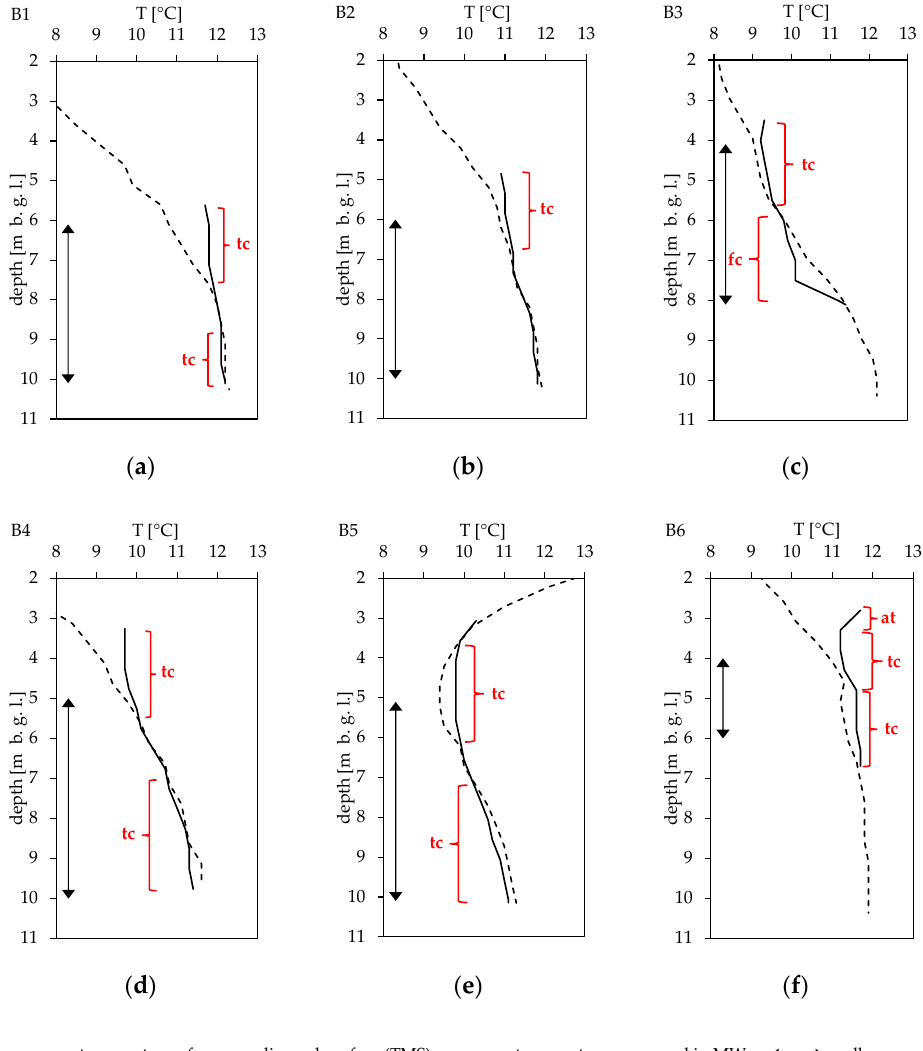
Figure 9. Temperature depth profiles in a MW and in surrounding subsurface and the dominant causes for temperature deviations: thermal convection (tc), forced convection (fc) or air temperature (at); ( a ) B1 in March; ( b ) B2 in April; ( c ) B3 in April; ( d ) B4 in March; ( e ) B5 in July; ( f ) B6 in April.